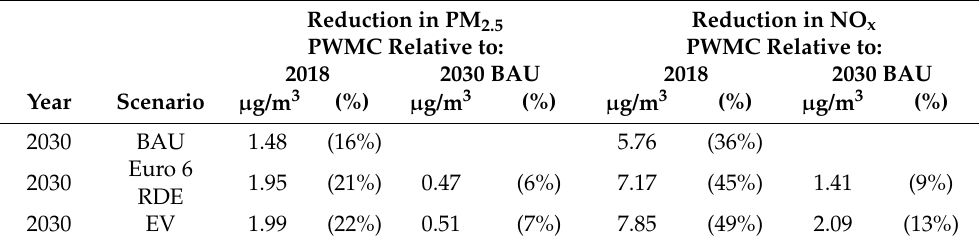
Table 2. Reductions of population weighted mean concentration (PWMC) for PM 2.5 and NO x for each scenario for the UK; the reduction in PWMC are relative to (i) 2018 and (ii) 2030 BAU scenarios; values in brackets show the change as a percentage.